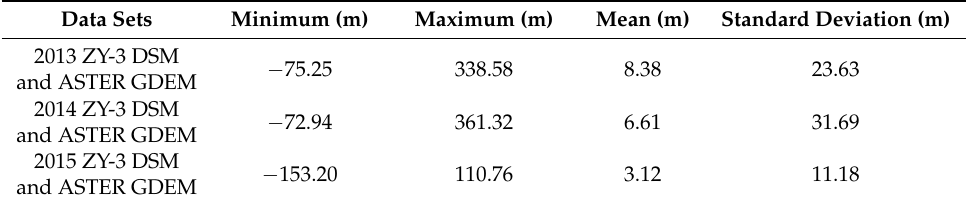
Table 3. Statistical results of elevation changes between ZY-3 DSMs and ASTER GDEM.